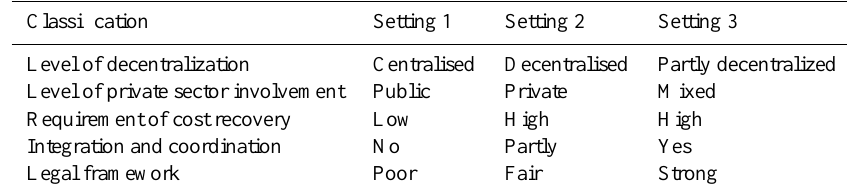
Table 3. Characteristics of institutional arrangements represented in Ravilla simulation